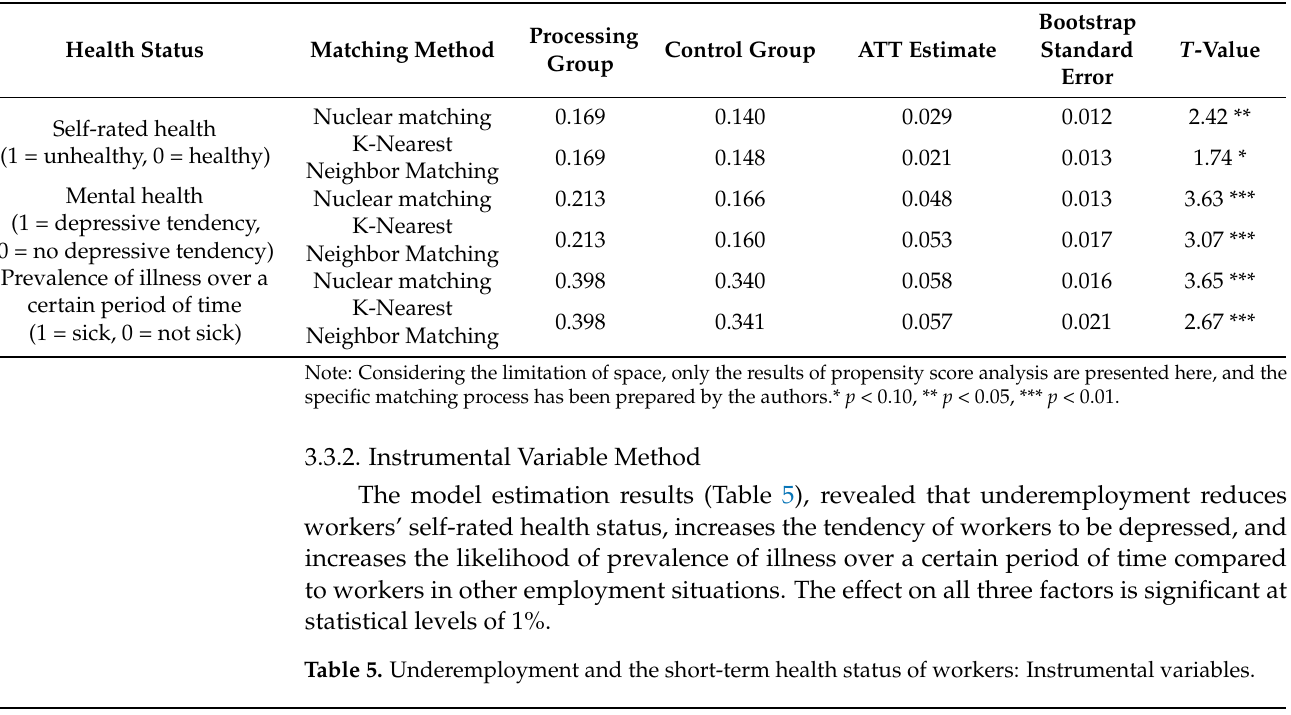
Table 4. Analysis of propensity score for underemployment and workers’ health status.